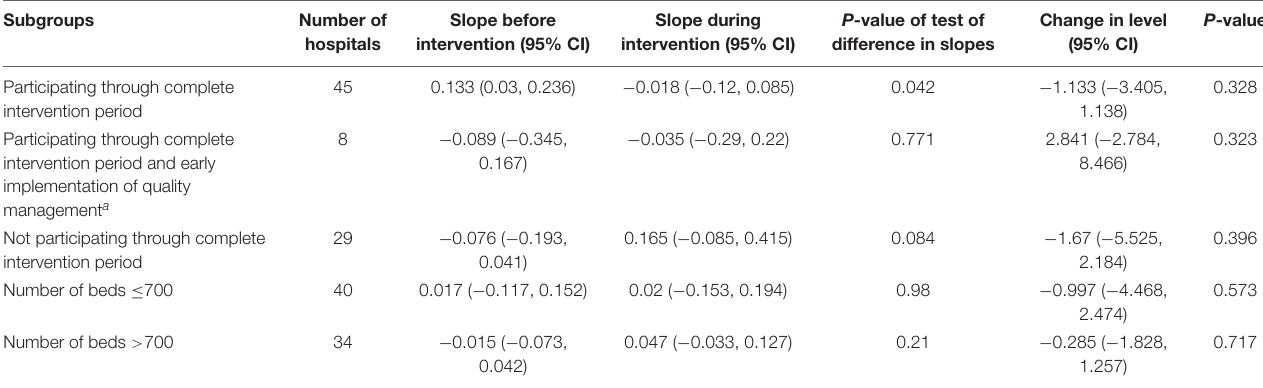
TABLE 3 | Results of interrupted time-series analysis in subgroups of participating hospitals.